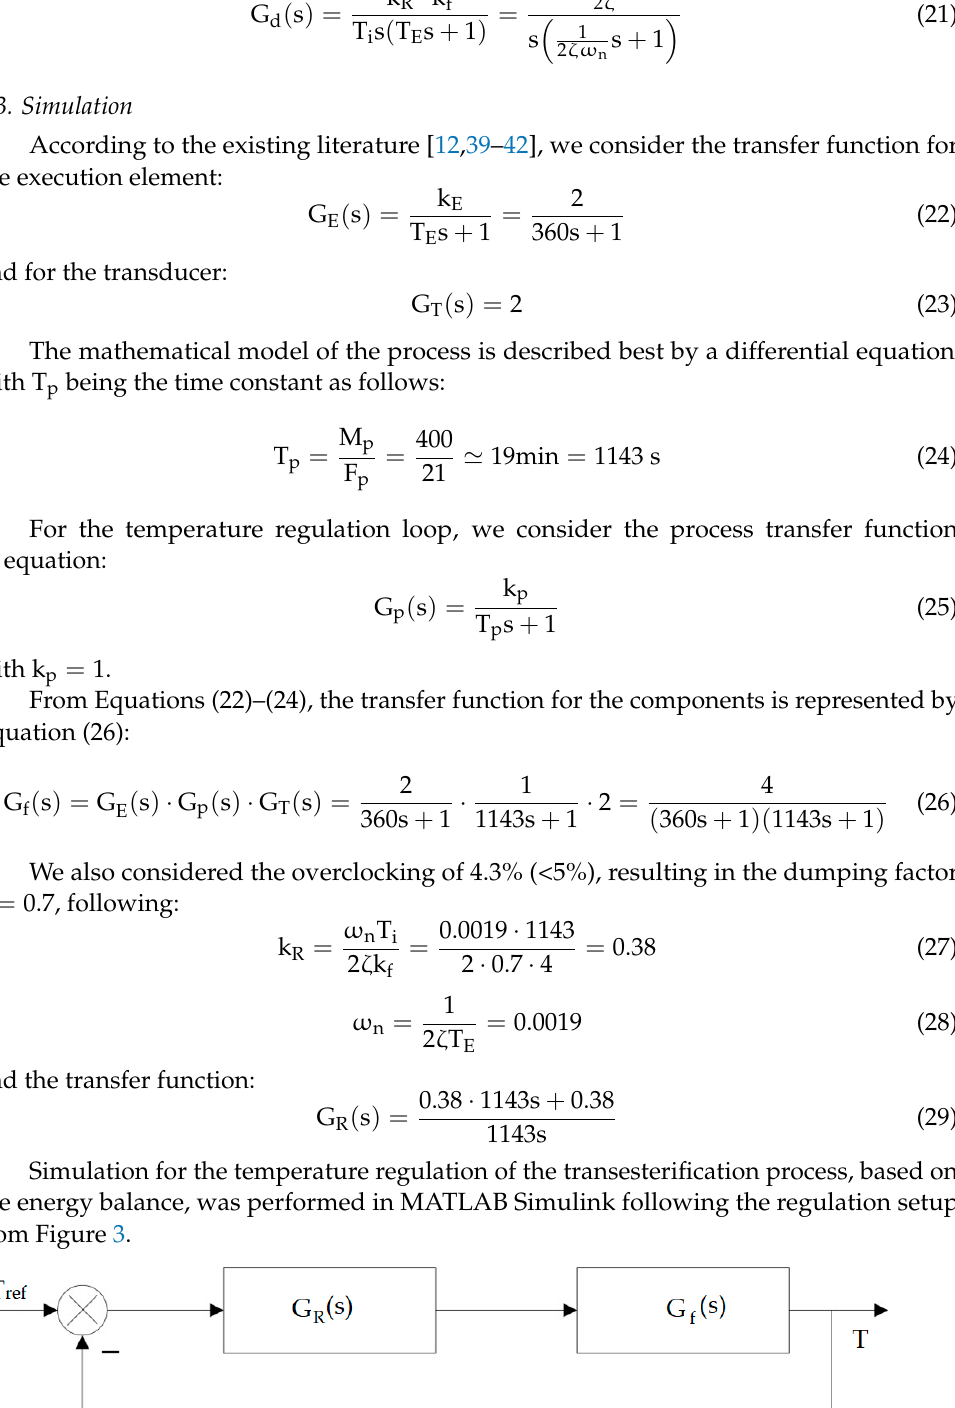
Figure 4. Temperature pro fi le curve. Based on the simulation, we identi fi ed the following performances of the automatic temperature control system: e (cid:2929)(cid:2930) = 0; σ = 3,75%; t (cid:2929) = 3008s (30) where e (cid:2929)(cid:2930) represents stationary error; σ — overclocking ; t (cid:2929) — stabilizing time, which demonstrates that by following the constraints imposed for obtaining the desired perfor- mances, and the regulator was designed correctly. The parameters used in the simulation were chosen based on the existing literature [12,39–41,43] and from repeated simulations in order to obtain a negligible stationary error and an overclock <5%, which was a tt ained. As the boiling point of methanol is 64.8 °C, the temperature in the reactor should not ex- ceed this value; therefore, the temperature was set at 60 °C. 3.4. Mathematical Approach—Validation of the Simulation Results For the mathematical modelling of the transesteri fi cation reaction, according to [37], the values for the speed constants k (cid:2869) … k (cid:2874) ranged from 0.007 to 1.23, and the activation energy E (cid:2869) … E (cid:2874) from 6400 to approximately 20,000, for soy oil using an alkali catalyst in a homogenous catalysis.